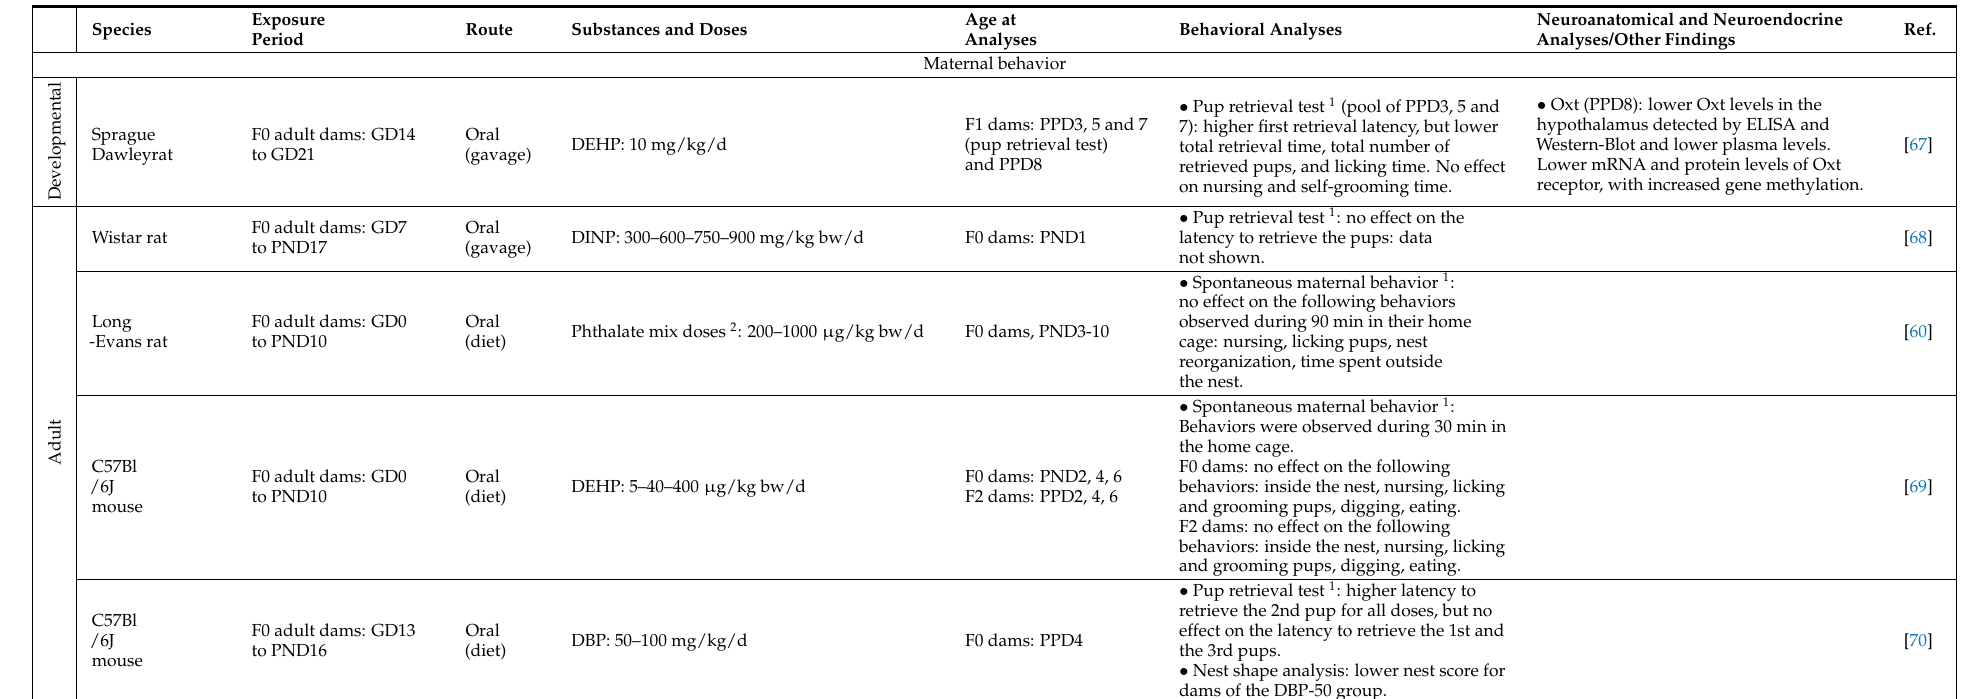
• Oxt (PPD8): lower Oxt levels in the hypothalamus detected by ELISA and Western-Blot and lower plasma levels. Lower mRNA and protein levels of Oxt receptor, with increased gene methylation.